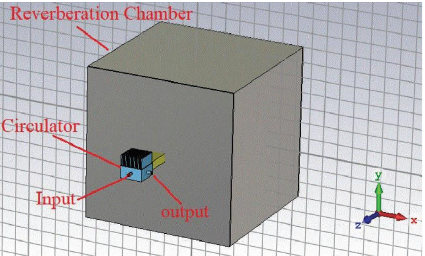
Figure 3: Te established improved simulation model with combined input and output, and the output USP signal is extracted through a high-power circulator.